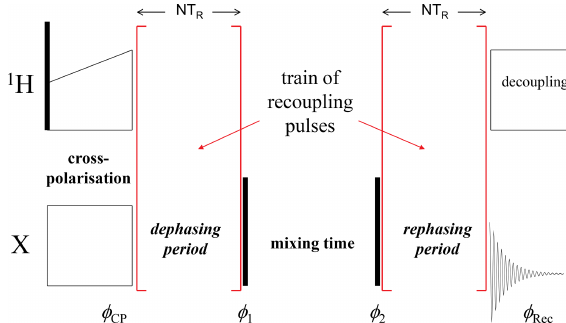
Figure 1. A simplified scheme of the CODEX pulse sequence. Black vertical bars denote π/ 2 pulses; ϕ CP , ϕ 1 , ϕ 2 and ϕ Rec are the phases of the X -channel cross-polarization (CP) pulse, two π/ 2 pulses and the receiver, respectively. The COS component is recorded when the phase differences are ϕ CP − ϕ 1 = π/ 2 and ϕ 2 − ϕ Rec = π/ 2; the SIN component corresponds to ϕ CP = ϕ 1 and ϕ 2 = ϕ Rec